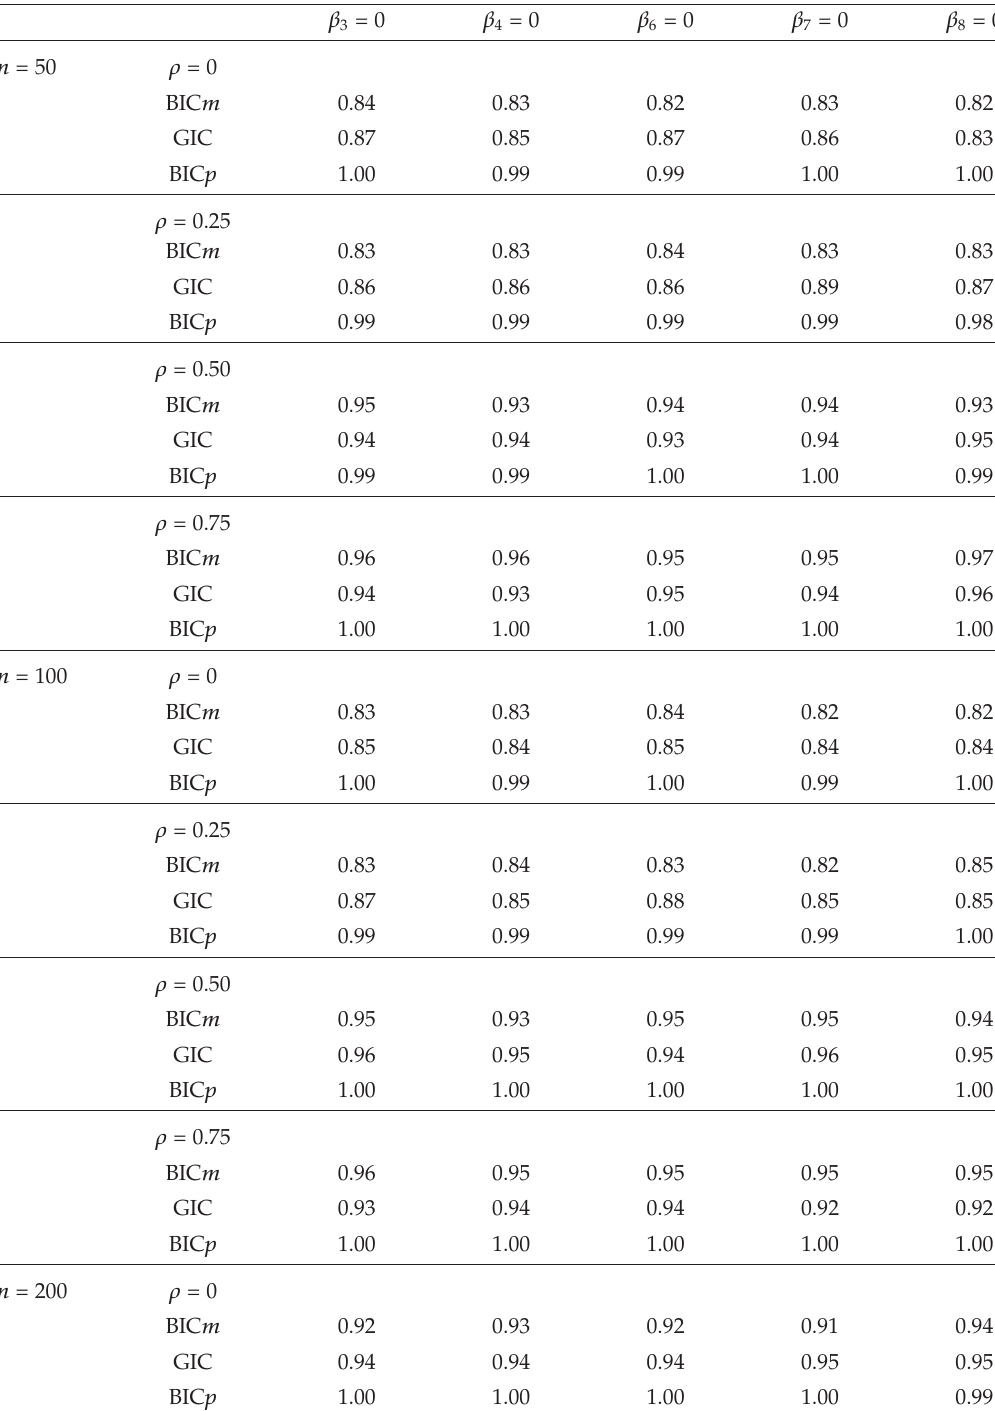
Table 9: Percentage of times β i is estimated as